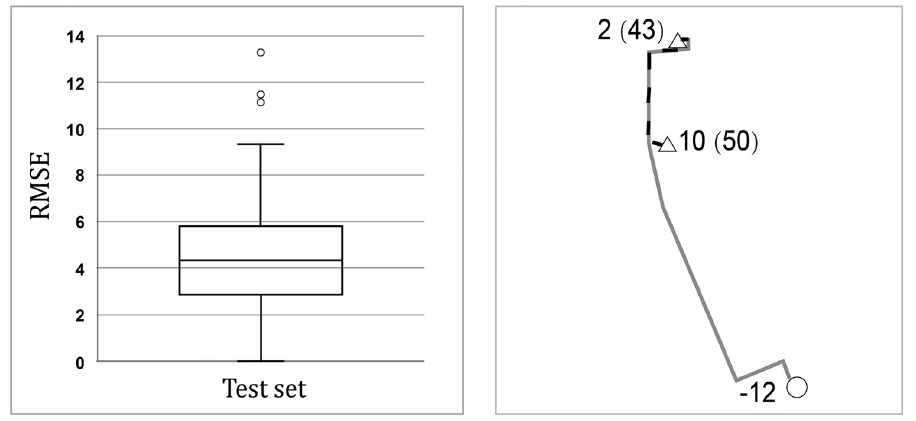
Fig 6. (a) The RMSE of demands forecasting on the test set; (b) A part of the best found route (solid line) and the path (dashed line) to the nearest feasible station having bikes to be delivered.